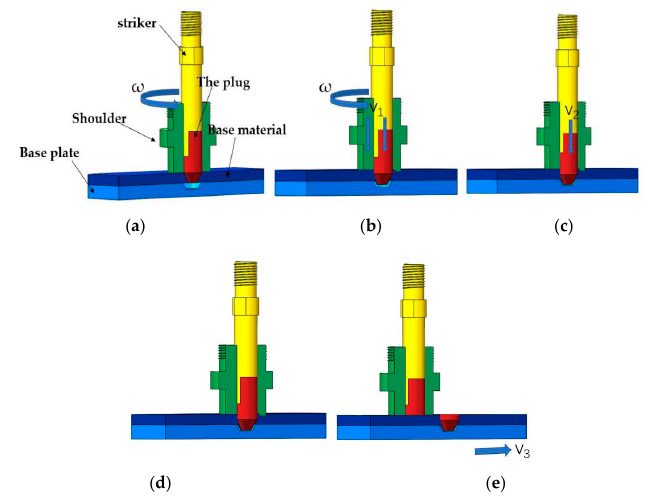
Figure 2. Schematic diagram of friction plug welding (FPW) process: ( a ) preheat phase, ( b ) friction feed phase, ( c ) upsetting phase, ( d ) pressure-holding phase, ( e ) disengagement phase.